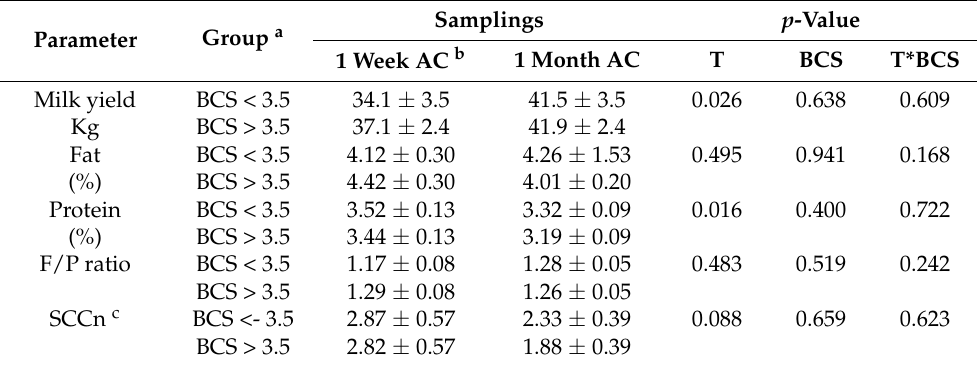
Table 2. Mean values ( ± standard error of the mean, SEM) of productive parameters depending on BCS group and their interactions during the study period.